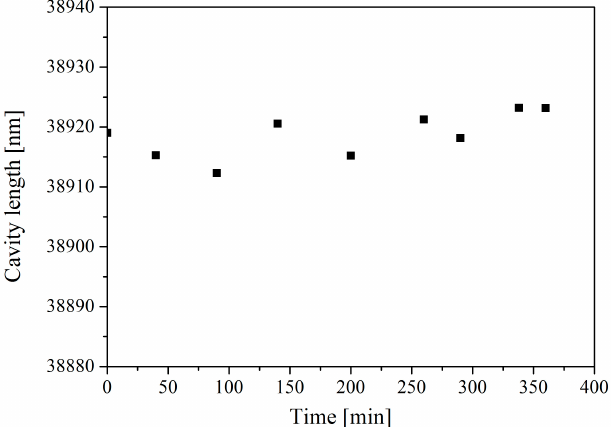
Figure 10. Cavity length as a function of pressures measured at room temperature.